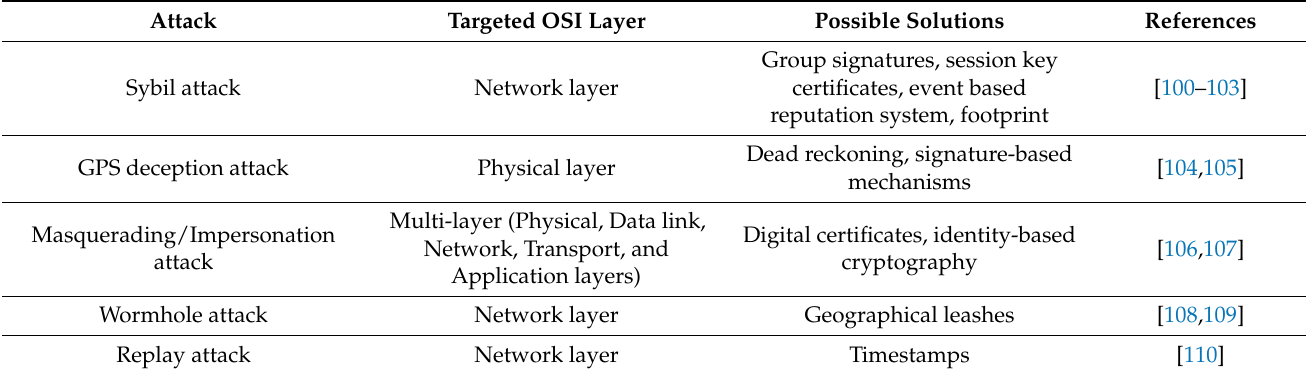
Table 3. Possible attacks on authentication, their targeted OSI layers, and